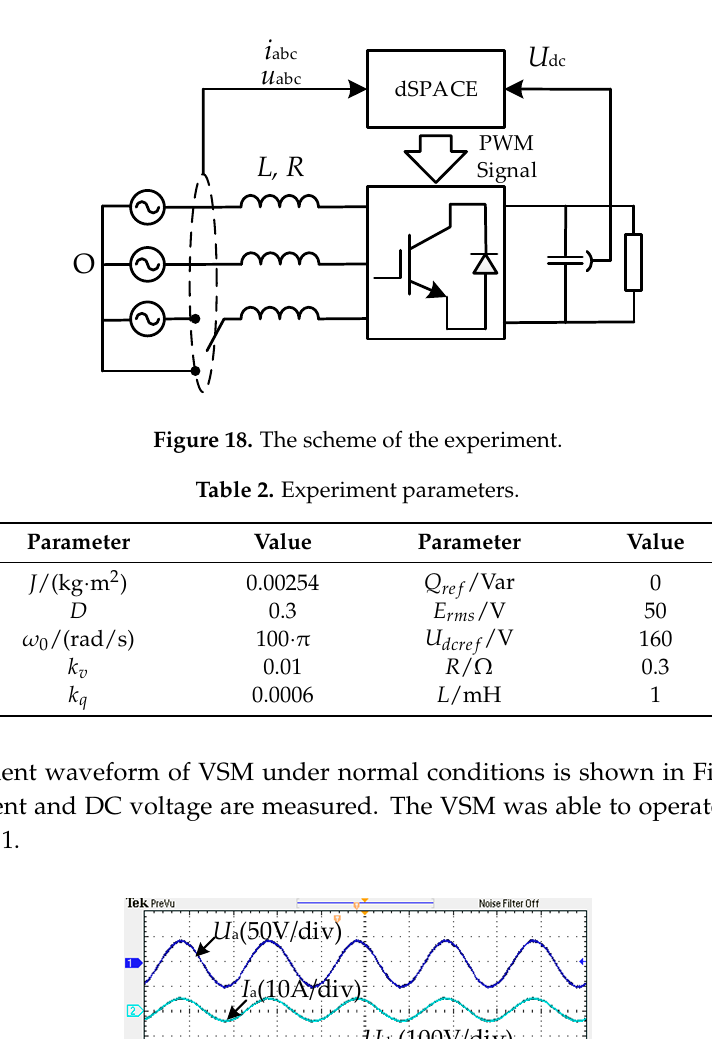
Figure 17. DC bus voltage with no ripples.